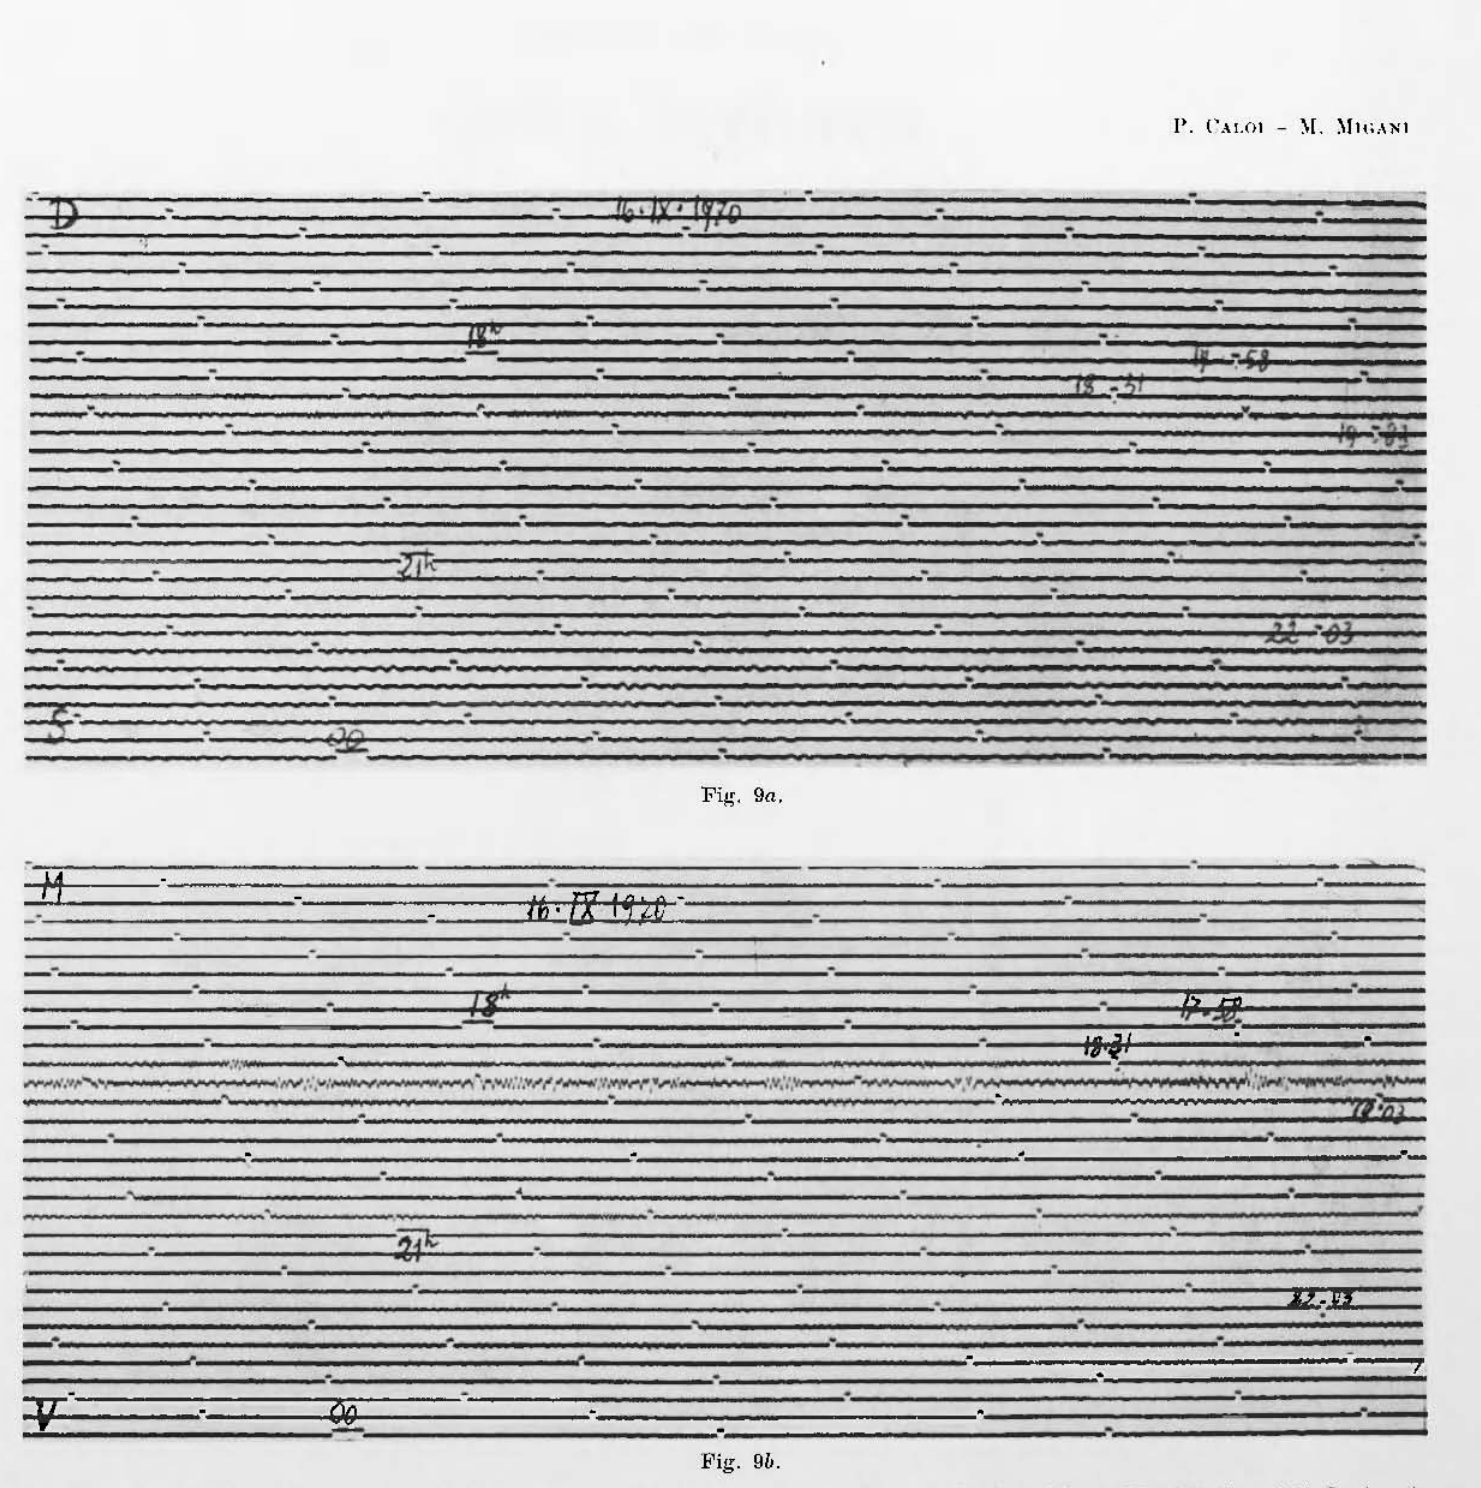
Fig. 9 - ?fi('.Toseisllls recorùeù in Picve di Cadore on occasioll of tho pa~sage oi tlle perturbation of ~eptember UI, 1970 (figures 7,8). 'l'Ile microseisms coming irom the lake appear distinctly less developed than tllose brought about by the cyclone oi July 15. 1970. Also tlle successive microseisms from tlle Gulf of Trieste, whicll reacheù Pievc after 10 h p.m. (more discernable on tlle right.left component., as the hill-valley component, aH a matter of fact, Ilad lost ali sensitivity in its regard), resulted much less developed than the analogous ones causeù by the cyclonc oi ,July 15, 1970. Besides, also their period, in tlle order of 2 sec., is slightly inferior to that observed on ,July 15, 1970. This is a proof that the microseismic I!torm originatingin the Gulf of Trieste on September 16, 1970 was associated to significant waves systems which had not yet reacheù their